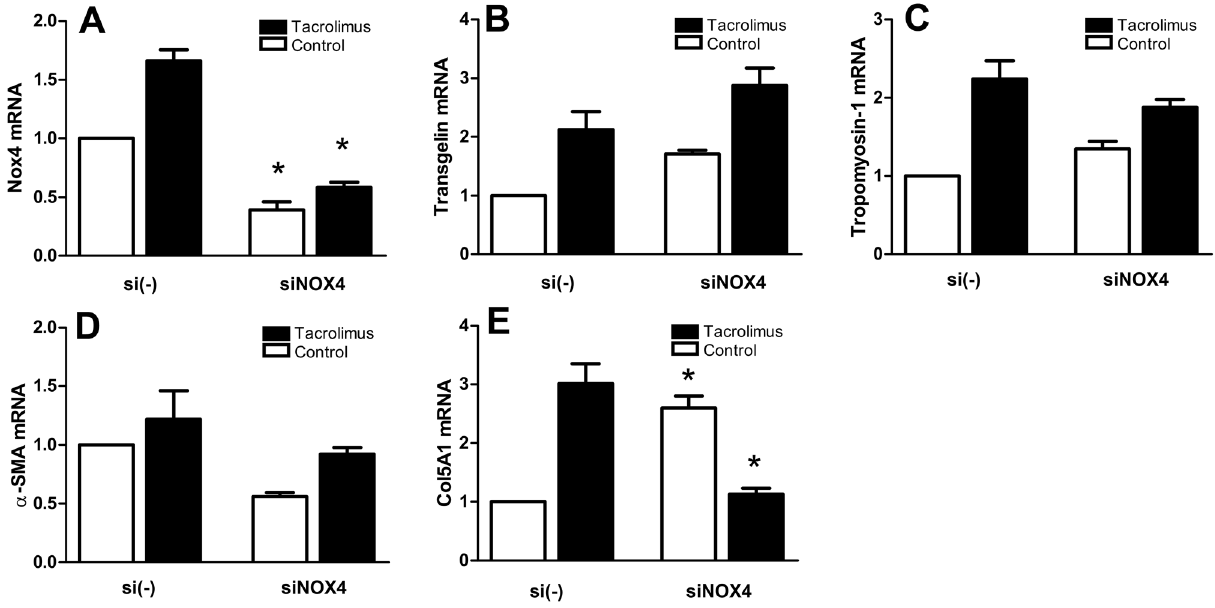
Figure 6. Effect of siRNA-mediated Nox-4 knock-down in human TK-173 fibroblasts. Cells were transfected with Nox4-targeted siRNA (siNOX4), or non-target siRNA (si(-)) as a control, resp., and exposed to 100 nM tacrolimus, or control conditions, for three days. Transfection with Nox4-targeted siRNA reduced Nox4 mRNA expression by 61% (untreated control), and 64% (100 nM tacrolimus), resp., compared to non-target siRNA transfected cells (A). Nox4 knock-down did not have significant effects on transgelin (B), tropomyosin-1 (C), and alpha-smooth muscle actin (D) mRNA expression, but induced a significant up-regulation of mRNA for procollagen a 1(V) in untreated cells, and a down-regulation to control levels in tacrolimus-treated cells (E). Results were normalized to control-transfected, untreated cells. (*) denotes significant (p # 0,05) differences between control-transfected and siRNA-transfected cells. dent curve of intracellular H 2 O 2 (Fig. 4C) mirrored the corresponding Nox4 mRNA expression curve (Fig. 2A) very well.